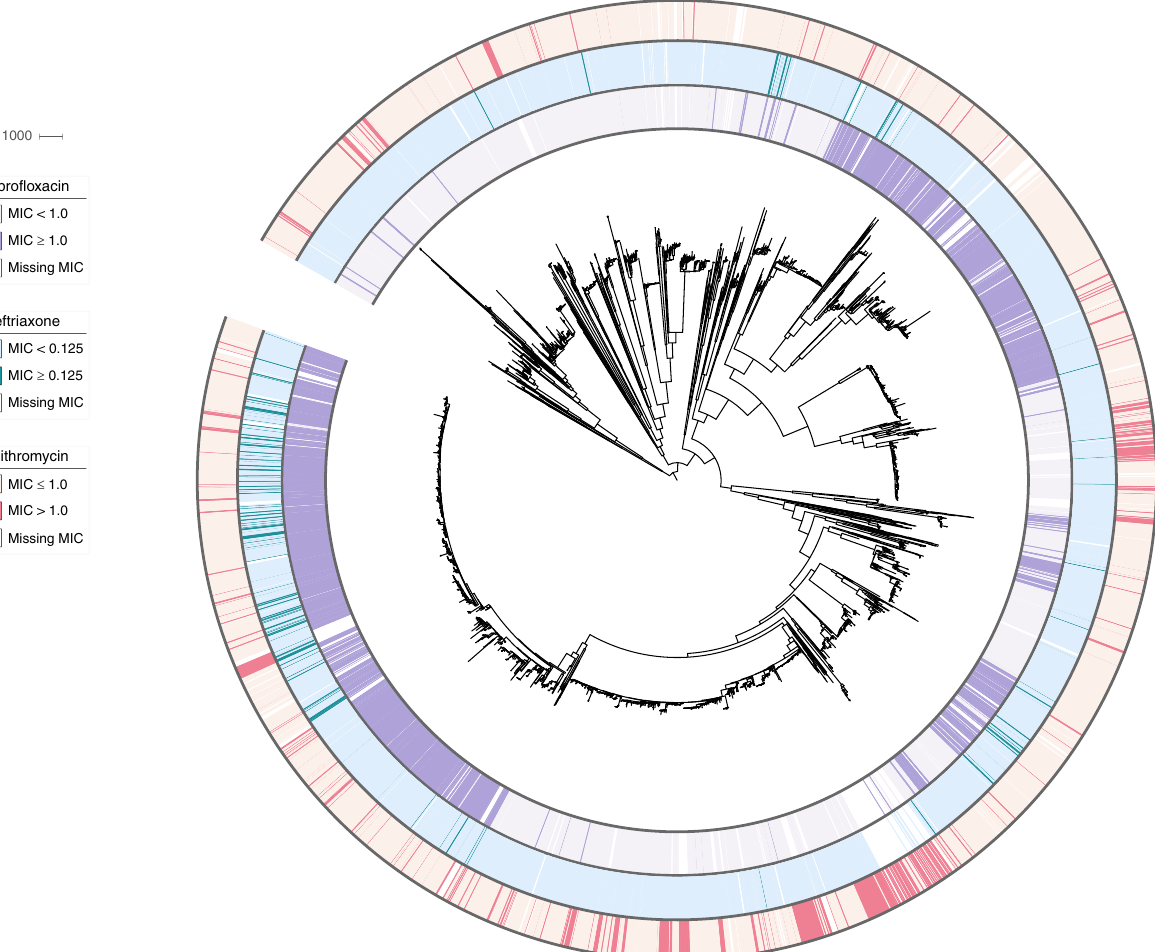
Fig. 1 Population structure and susceptibility pro fi le of N. gonorrhoeae global meta-analysis collection. A midpoint rooted recombination-corrected maximum likelihood phylogeny of 4852 genomes based on 68697 SNPs (Supplementary Table 1) was annotated with binarized resistance (cipro fl oxacin) or decreased susceptibility (azithromycin, ceftriaxone) values. Annotation rings are listed in order of cipro fl oxacin, ceftriaxone, and azithromycin from innermost to outermost. For cipro fl oxacin, MIC < 1 μ g/ml is light purple, and MIC ≥ 1 μ g/ml is dark purple. For ceftriaxone, MIC < 0.125 μ g/ml is light blue, and MIC ≥ 0.125 μ g/ml is dark blue. For azithromycin, MIC ≤ 1 μ g/ml is light pink, and MIC > 1 μ g/ml is dark pink. Branch length represents total number of substitutions after removal of predicted